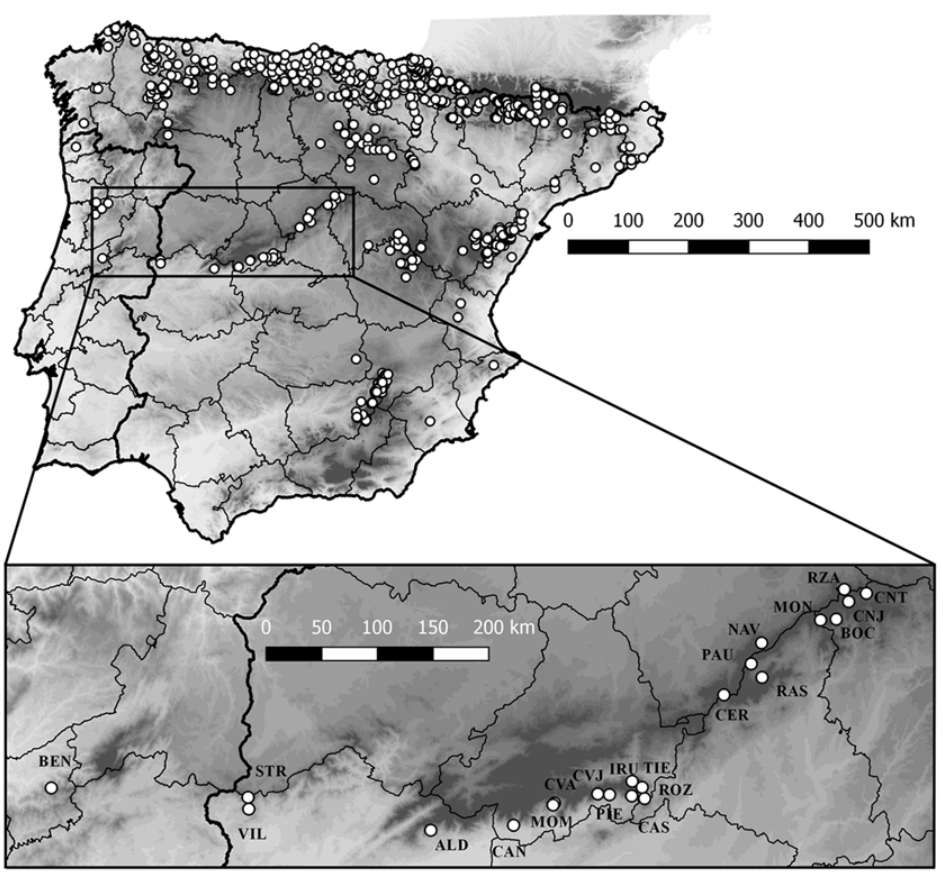
Figure 1. Map depicts the locations of Ulmus glabra populations in the Iberian Peninsula. The details of distribution of the studied populations along the Central System are shown in the rectangle (see Table 1 for codes).